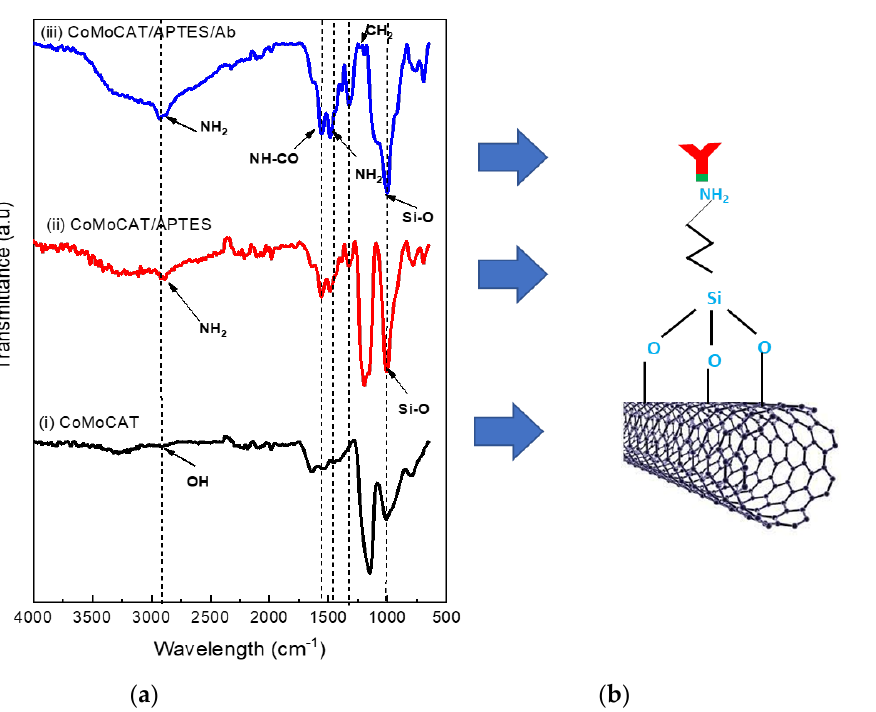
Figure 9. Surface functionalisation characteristics of the CoMoCAT SG 65 SWCNT thin-film net- work; ( a ) FTIR spectra absorption of ( i ) bare SWCNTs, ( ii ) SWCNTs functionalised with APTES, ( iii ) APTES-functionalised-SWCNTs immobilised with Ab; ( b ) an illustration of the Ab/APTES-modi- fied SWCNTs.